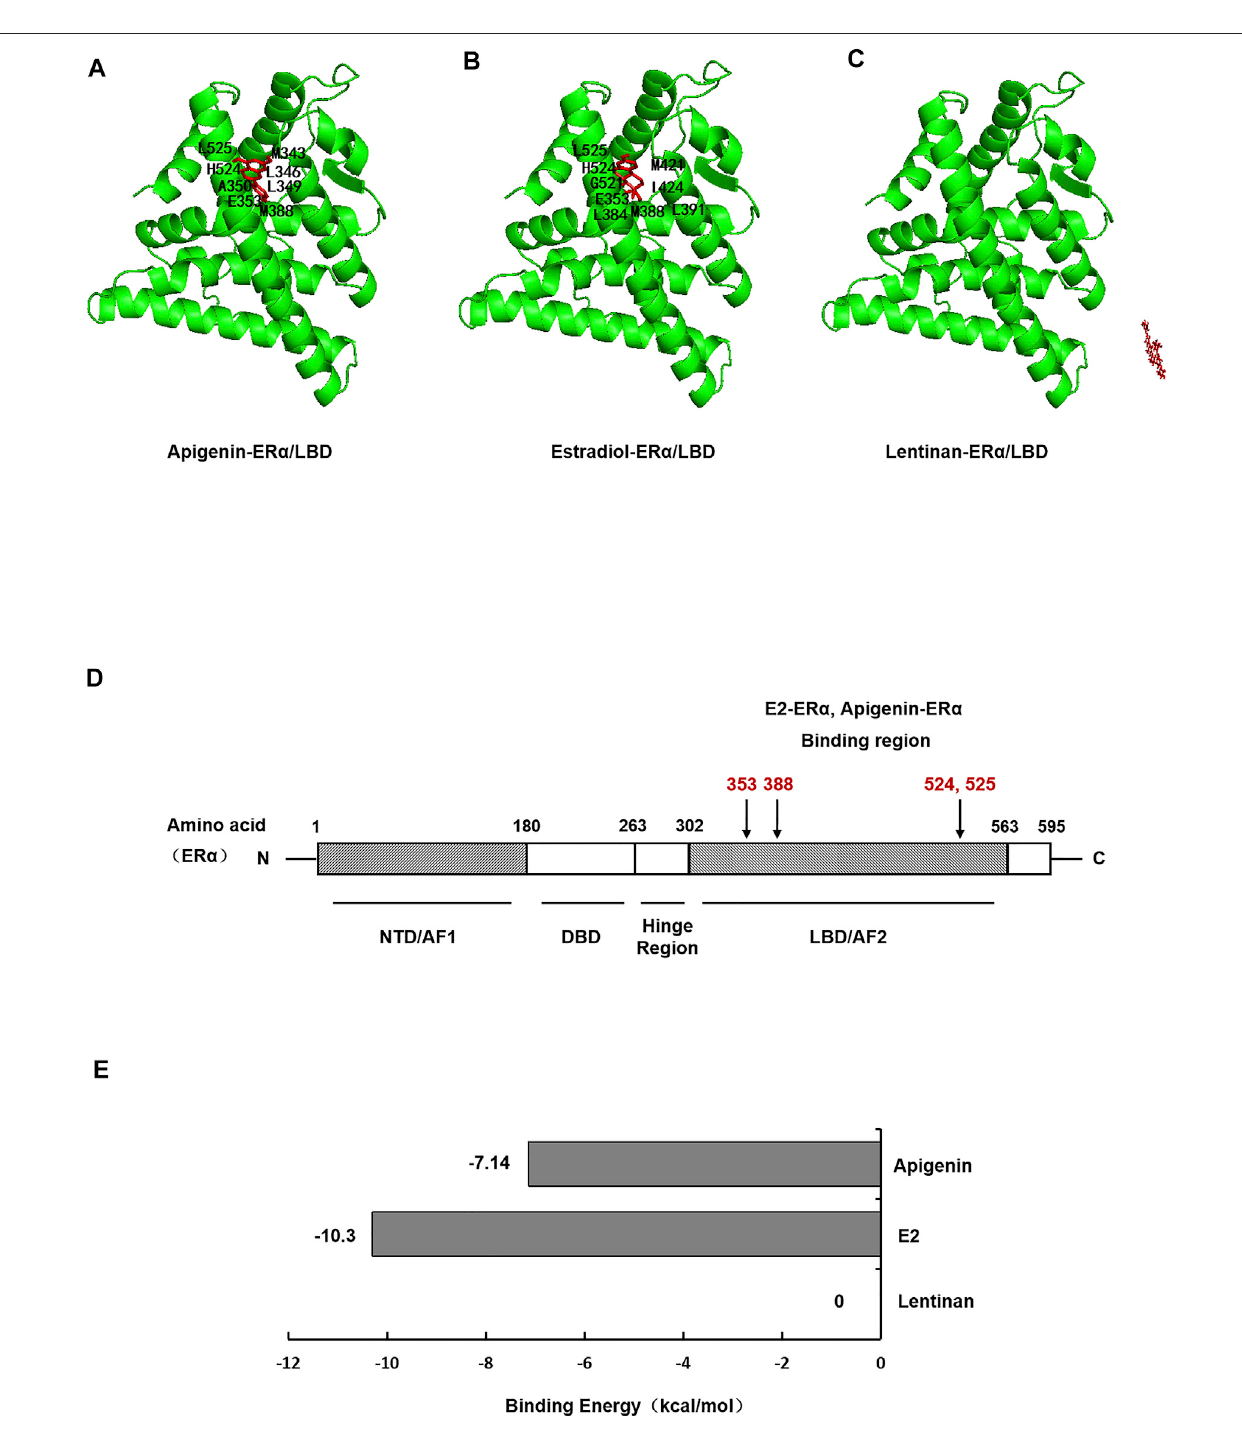
FIGURE 4 | Molecular docking shows speci fi c binding of apigenin to ER α within the E2-ligand binding domain. Images showing the binding site of apigenin (A) , E2 (B) , and lentinan (C) inER α . (D) Interaction ofamino acidresidues located intheligand binding domain (LBD) ofER α . (E) Bindingenergy ofapigenin, E2, and lentinan with ER α